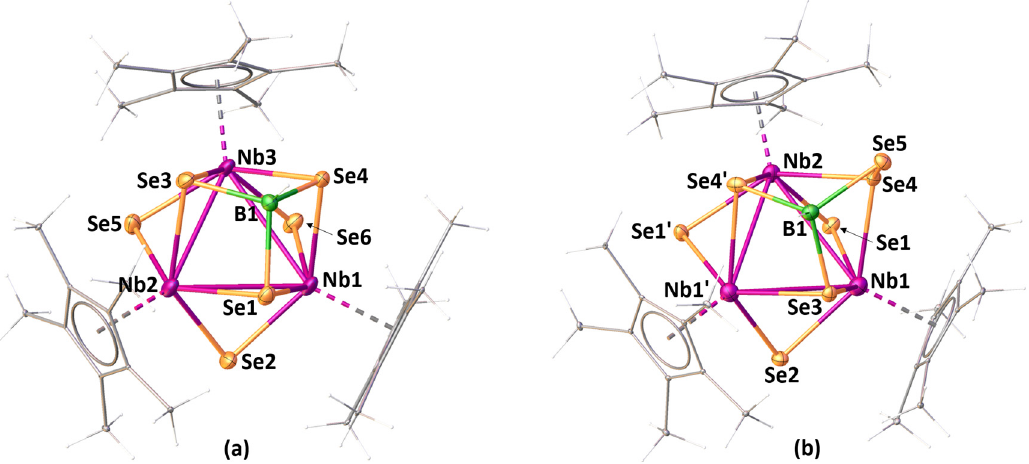
Figure 1. Molecular structures and labelling diagrams of 1 ( a ) and 2 ( b ). Selected bond lengths (Å) and angles (deg) in 1 : Nb1-Nb2 3.270(2), Nb1-Nb3 3.271(2), Nb2-Nb3 3.272(3), B1-Se3 2.07(3), B1-Se4 2.11(3), Nb1-Se1 2.672(3), Nb2-Se3 2.670(3); Nb1-Nb3-Nb2 59.96(5), Se1-B1-Se4 97.8(13), Nb1-Se1- Nb2 75.47(8); in 2 : Nb1-Nb1 ′ 3.254(5), Nb1-Nb2 3.307(4), Nb1-Se4 2.669(4), Nb2-Se4 2.639(4), Se4-Se5 2.210(7), B1-Se5 2.07(3), B1-Se3 2.08(3); Nb1-Nb2-Nb1 ′ 58.94(10), Nb1-Nb1 ′ -Nb2 60.53(5), B1-Se5-Se4 86.4(17), Se3-B1-Se5 107.7(18), Nb2-Se4-Nb1 77.07(12).